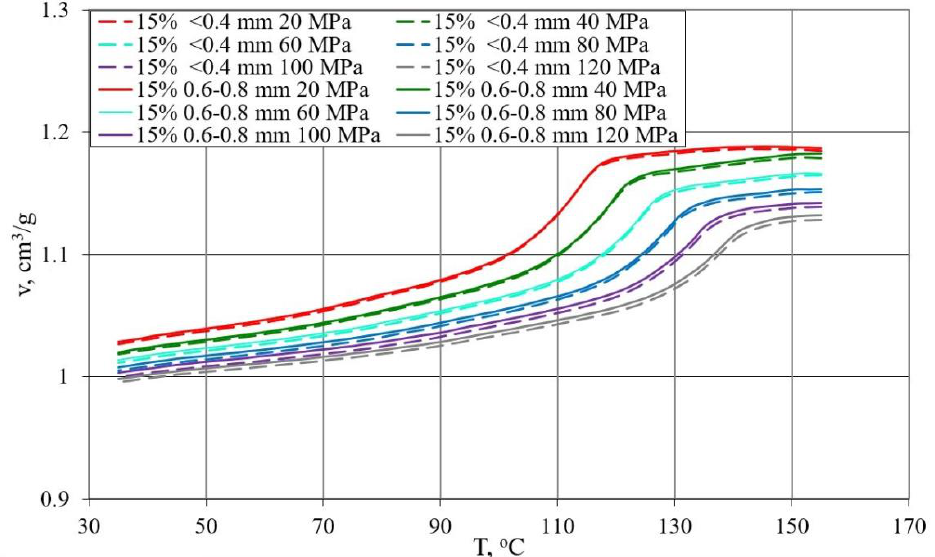
Figure 16. Dependence of specific volume v on temperature T for PE with 15% content of bran fraction <0.4 mm (dashed lines), and 0.6 – 0.8 mm fraction (continuous lines) at different pressure values.